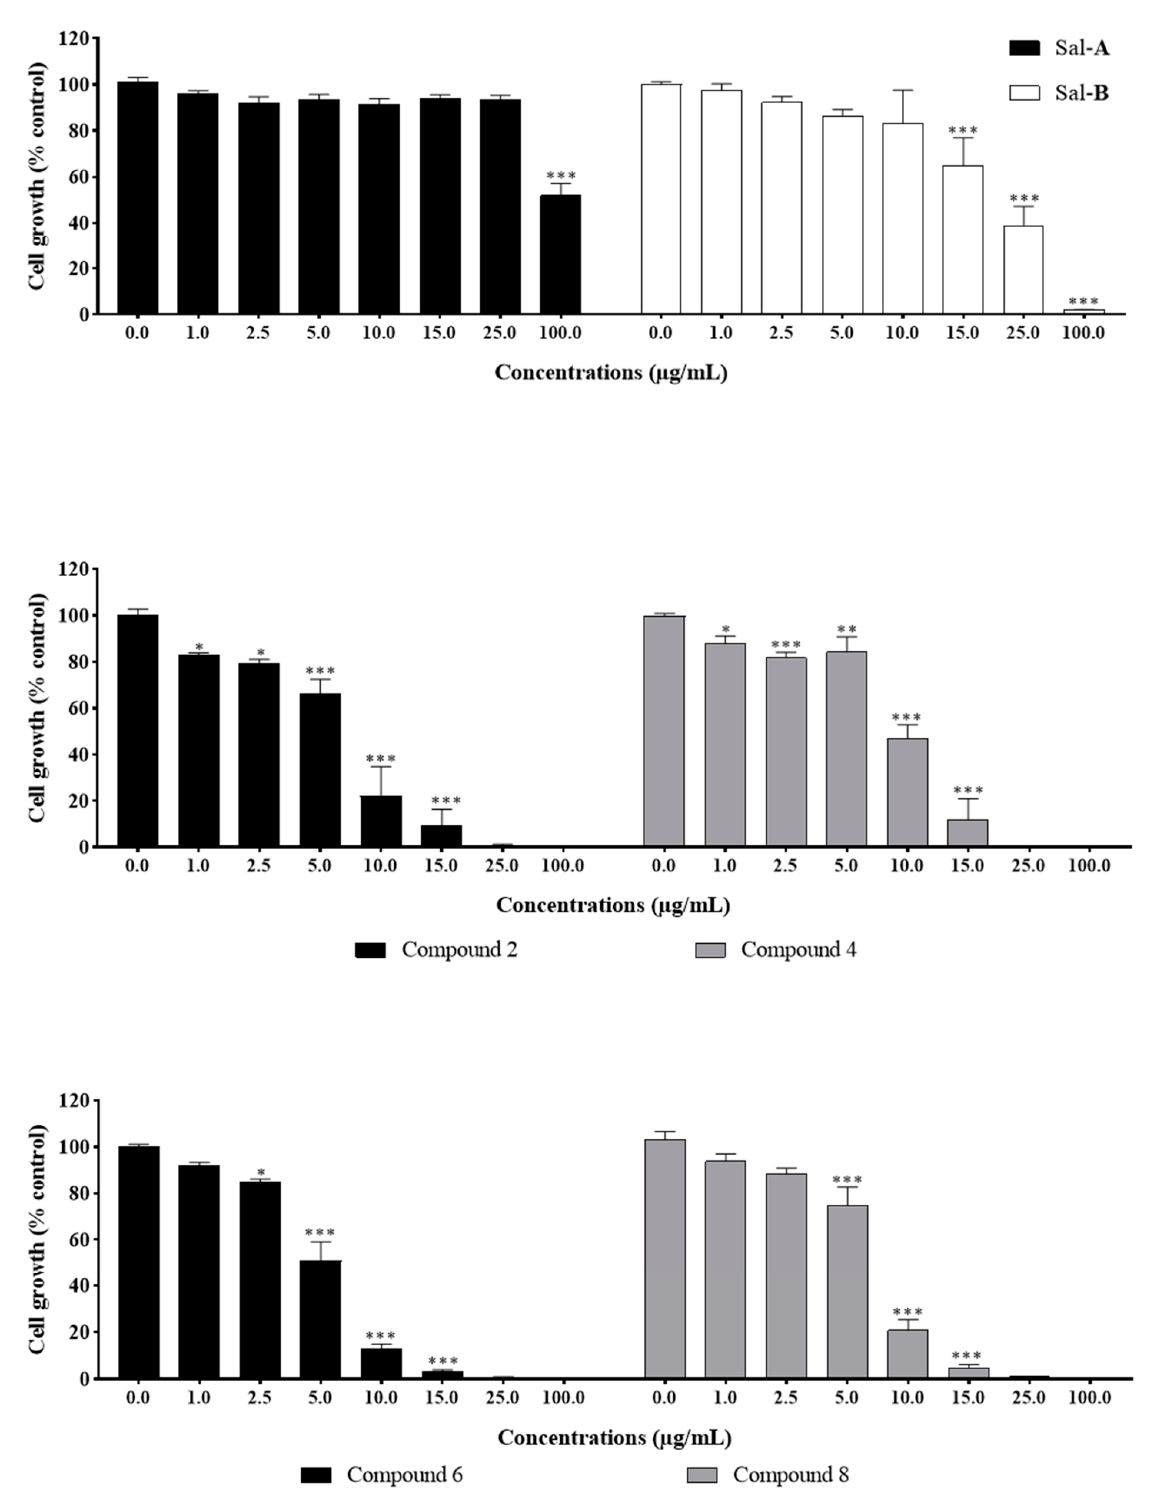
Figure 4. Effect of Sal- A , Sal- B , and their most potent derivatives on the growth of the normal-like NCM460 cells. Cells were treated with 1% DMSO (control) or the indicated concentrations of the compounds for up to two days. Cell growth was determined in triplicate wells using the MTT cell proliferation assay. Results are expressed as percentage of control and represent the average of three independent experiments ± SEM. Statistical significance is reported by two-way ANOVA post hoc Bonferroni’s multiple comparisons test indicating differences between treated cells and control at 48 h post-treatment (*, p < 0.05; **, p < 0.01; ***, p < 0.001).